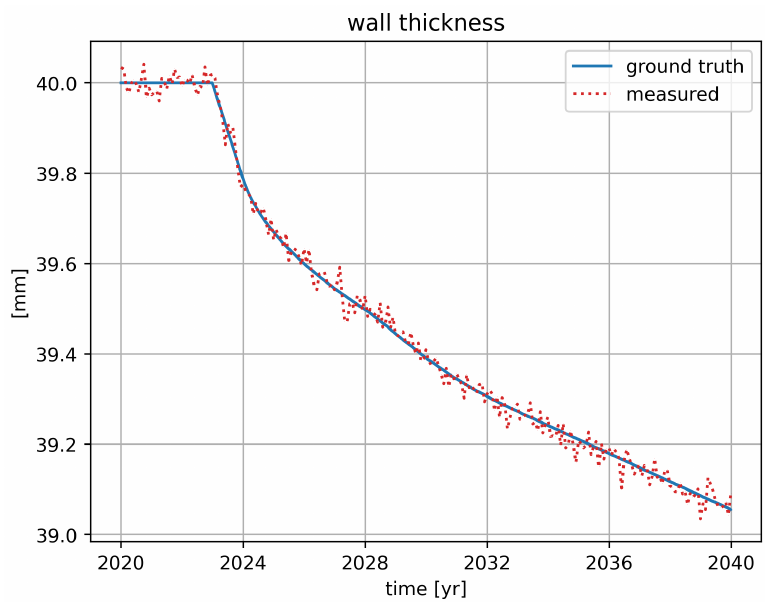
Figure 1. A dataset of simulated wall thickness measurements (a Gaussian measurement noise with a standard deviation of 20 µ m is used here) along with the ground truth and the corresponding corrosion rate and corrosion loss. Only the wall thickness measurements are used in the corrosion detection and corrosion